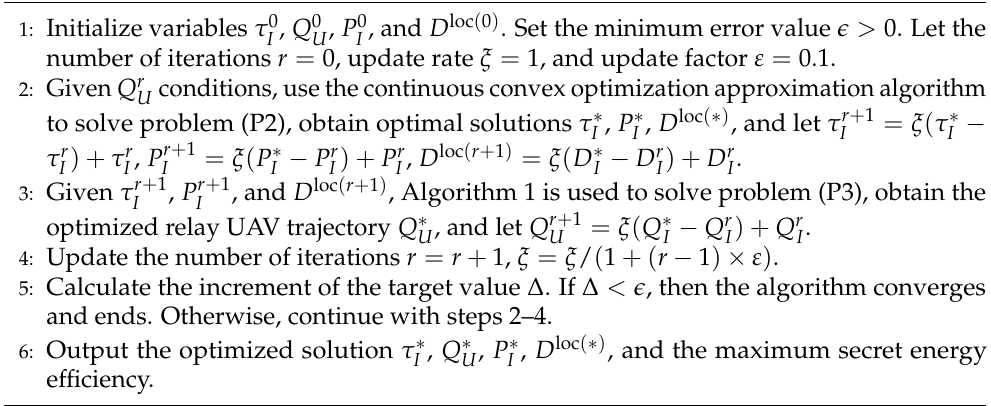
Algorithm 2 Joint Optimization Algorithm for Maximizing Energy